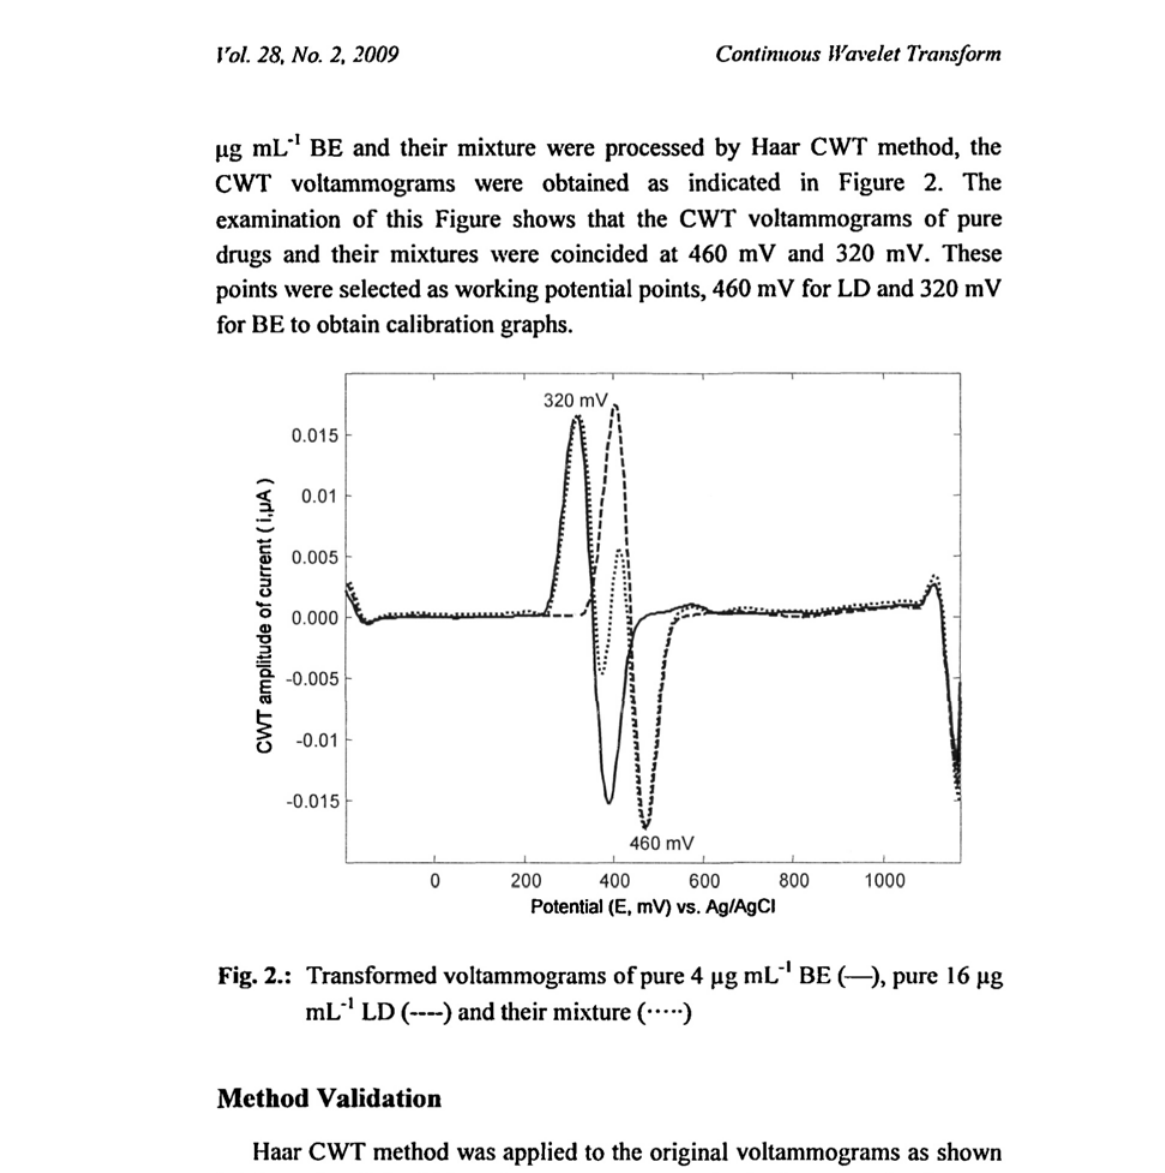
Fig. 2.: Transformed voltammograms of pure 4 μg mL" 1 BE (—), pure 16 μg mL" 1 LD (—) and their mixture ( ) Method